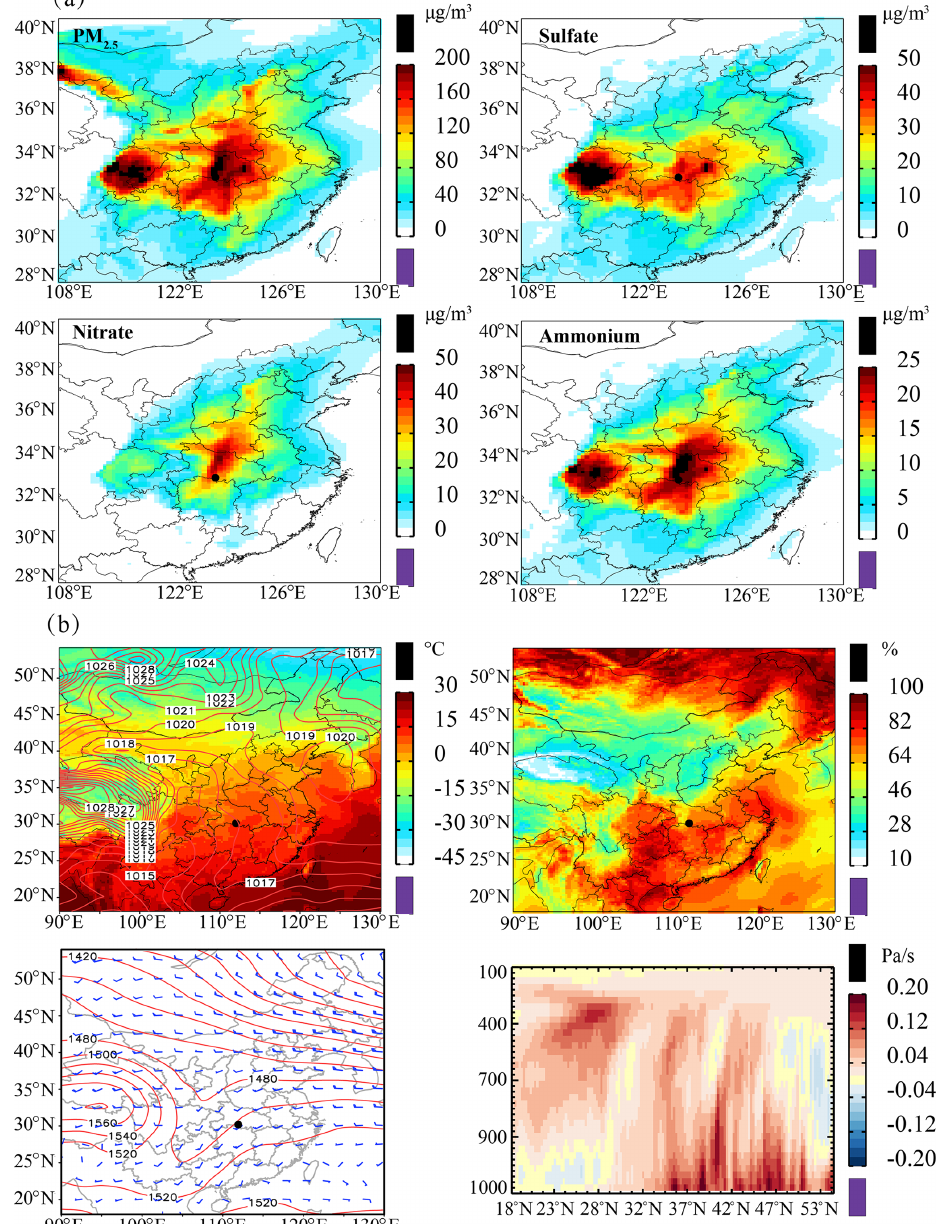
Figure 11. The same as in Fig. 7 but for C-type synoptic control (26 January–2 February